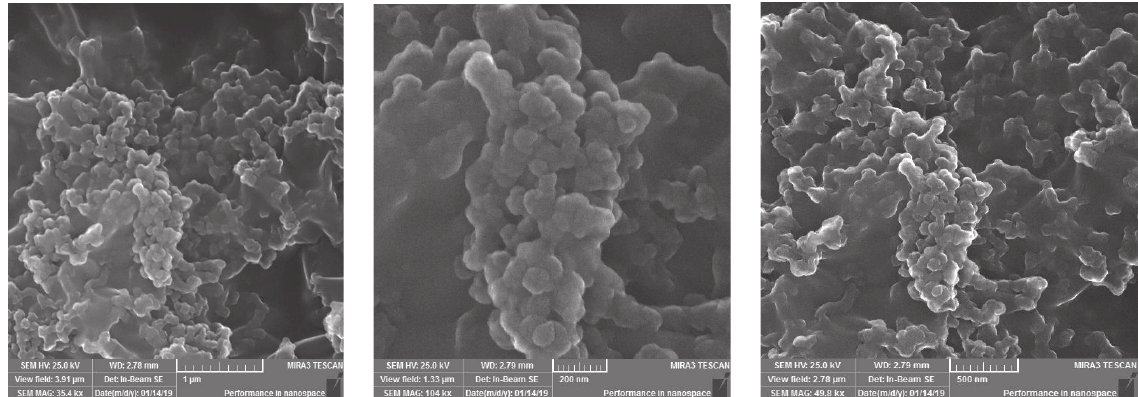
Figure 2: SEM analysis of AgNP synthesized from Camellia sinensis.